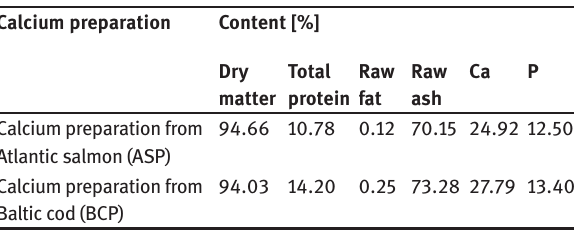
Table 3: Physico-chemical parameters of the final calcium preparations. Calcium preparation